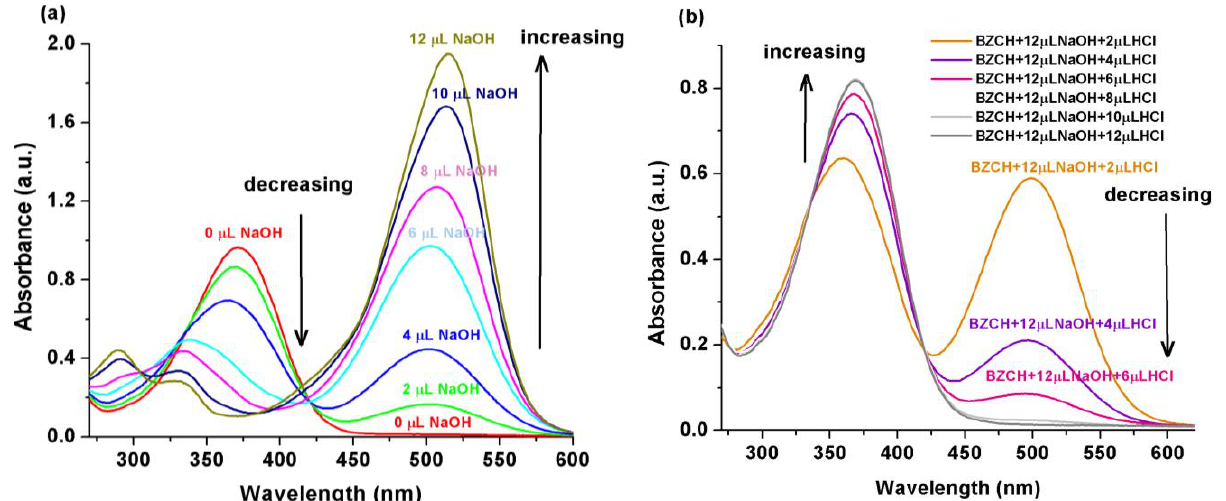
Figure 3. Absorption spectral changes of BZCH in DMSO induced by the titrations with dilute (0.1 N) NaOH ( a ) and followed by the addition of dilute HCl solutions ( b ).